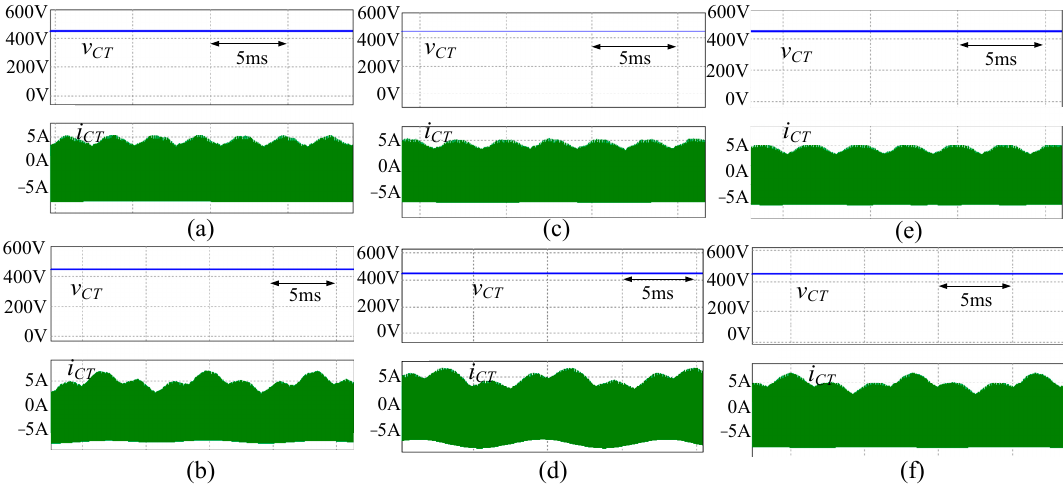
Figure 8. The simulated voltage v CT and current i CT of the DC-link capacitor under test for ( a , c , e ) balanced and ( b , d , f ) unbalanced load condition in the ( a , b ) full-scale voltage rating VSI, ( c , d ) conventional down-scale voltage rating evaluation system, and ( e , f ) proposed down-scale voltage rating evaluation system.